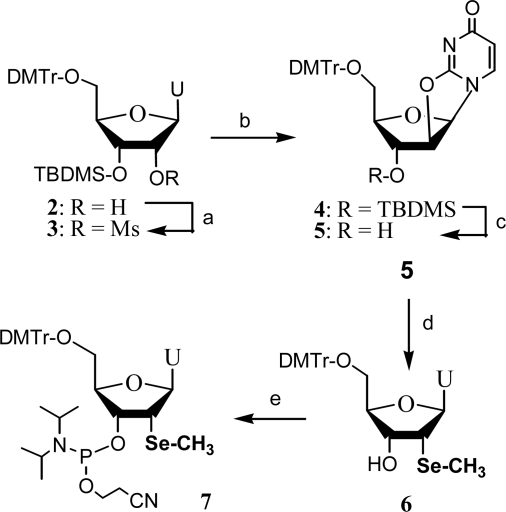
Synthesis of 2’-methylseleno contained uridine phosphoramidite and its incorporation into oligonucleotides. (a) MsCl/THF/TEA, 95% yield; (b) toluene/tetrahexylammonium hydrogen sulfate/Na2CO3 (sat.), 96% yield; (c) (Bu)4N+ F−, 95% yield; (d) NaHSe, then CH3I, or NaSeCH3, 96%; (e) PCl(OCH2CH2CN)N(iPr)2, 92% yield.